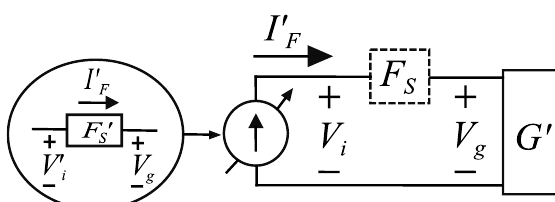
Figure 3. A current-controlled inverter with a sufficiently fast PI loop can enforce any I (cid:48) a simulated output voltage V (cid:48) When the virtual and hardware filters do not match F (cid:48)